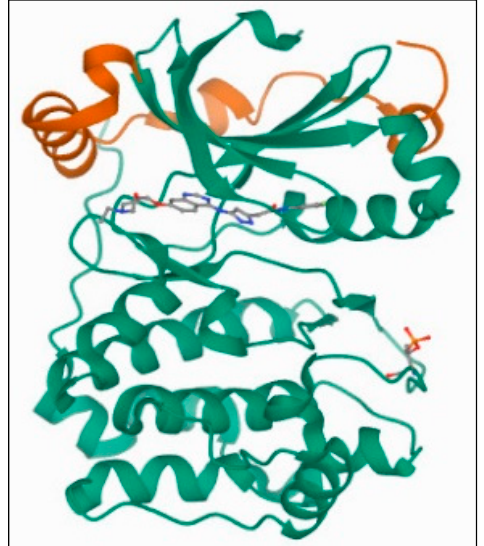
Figure 12. XRD crystal structure of the Aurora-B-INCENP complexed to inhibitor Barasertib. The kinases were prepared by deleting the covalent connectivities of the bound ligand